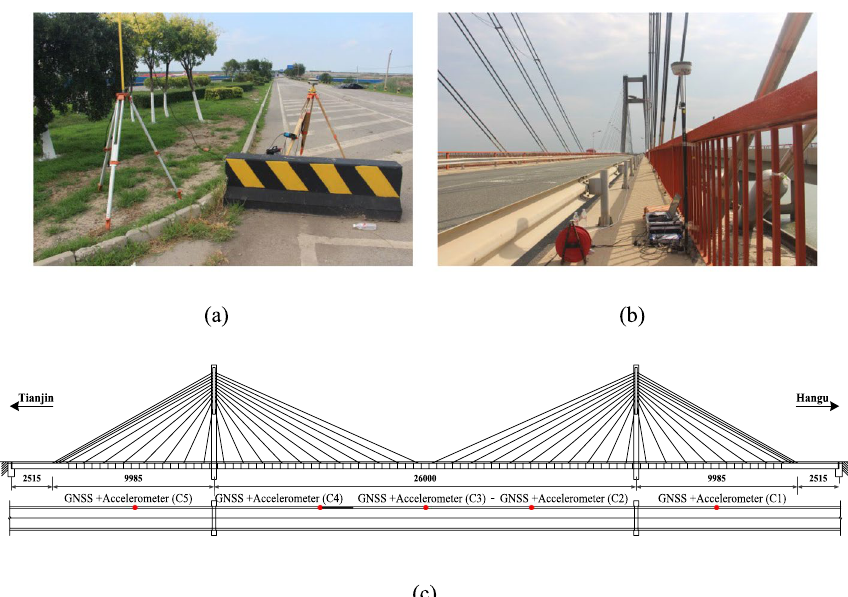
Fig. 9 Schematic figure for the field measurement: ( a ) GNSS reference station; ( b ) GNSS rover station and accelerometer sensor; ( c ) The position of measuring points